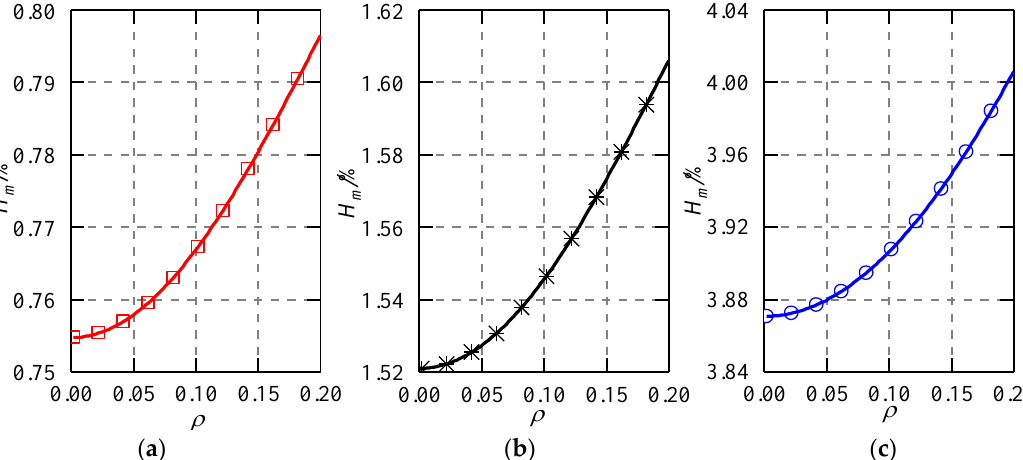
Figure 8. Maximum attitude error caused by shape deviation of the ball. ( a ) Δ r = 1 μm, ( b ) Δ r = 2 μm, ( c ) Δ r = 5 μm.